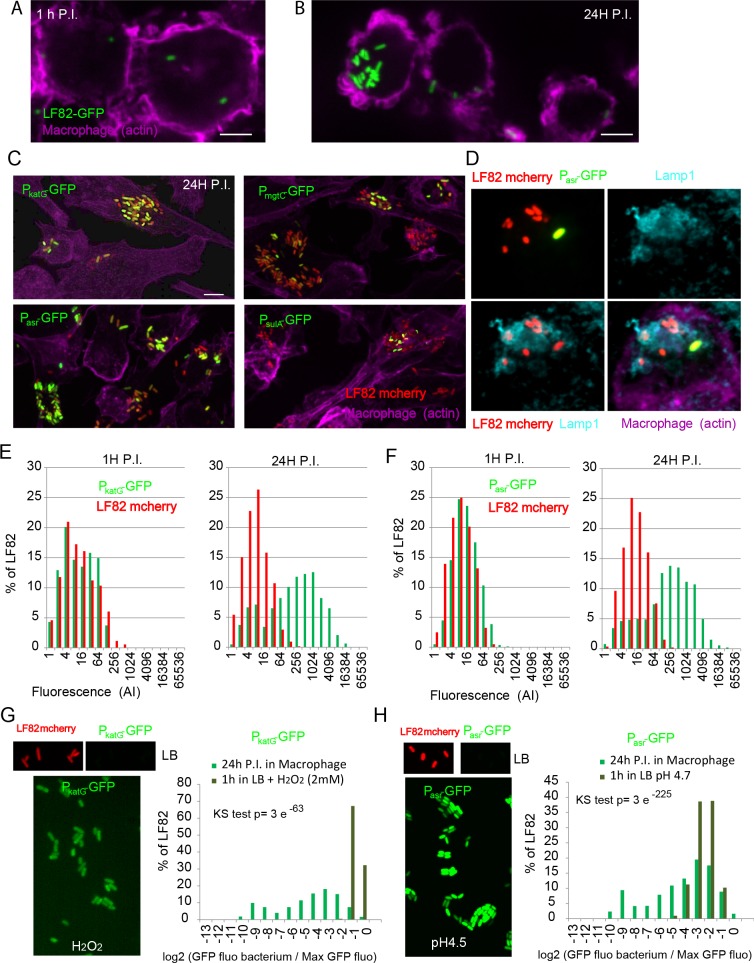
Intracellular LF82 show heterogeneous stress responses.A) Imaging of THP1 macrophages infection by LF82-GFP at a MOI of 30. Representative images at 1 h P.I.. Scale bar is 5 μm. B) Imaging of LF82-GFP at 24 h P.I.. C) Imaging of LF82-mCherry stress responses at the single cell level with biosensors. Imaging was performed at 24 h P.I.. LF82-mCherry was transformed with plasmids containing either the katG promoter fused to GFP (PkatG-GFP), the mgtC promoter (PmgtC-GFP), the asr promoter (Pasr-GFP) or the sulA promoter (PsulA-GFP). D) Imaging of LF82-mCherry PasrGFP and Lamp1 phagolysosome marker. E) Measure of the fluorescence intensity of individual LF82-mCherry containing the katG promoter fused to GFP at 1 h and 24 h P.I. Fluorescence was measured on images acquired on fixed bacteria immediately after macrophage lysis (N = 2000) with a spinning disk microscope F) Measure of the fluorescence intensity of individual LF82-mCherry containing the asr promoter fused to GFP at 1 h and 24 h P.I. (N = 2000). G) LF82 PsulA-GFP, LF82 PkatGGFP, LF82 Pasr-GFP in LB and 1h after addition of MMC (5μM), H2O2 (5μM) or switched to pH4.7 1h before imaging. Distribution of the fluorescence of LF82 Pasr-GFP after 24h post infection in macrophage (from panel B) and after 1 hours of growth in LB buffered at pH4.7. Fluorescence values were expressed as their log2ratio with the average value of the maximum decile (maximum expression). Distributions were compared with a Two-sample Kolmogorov-Smirnov (KS) test.